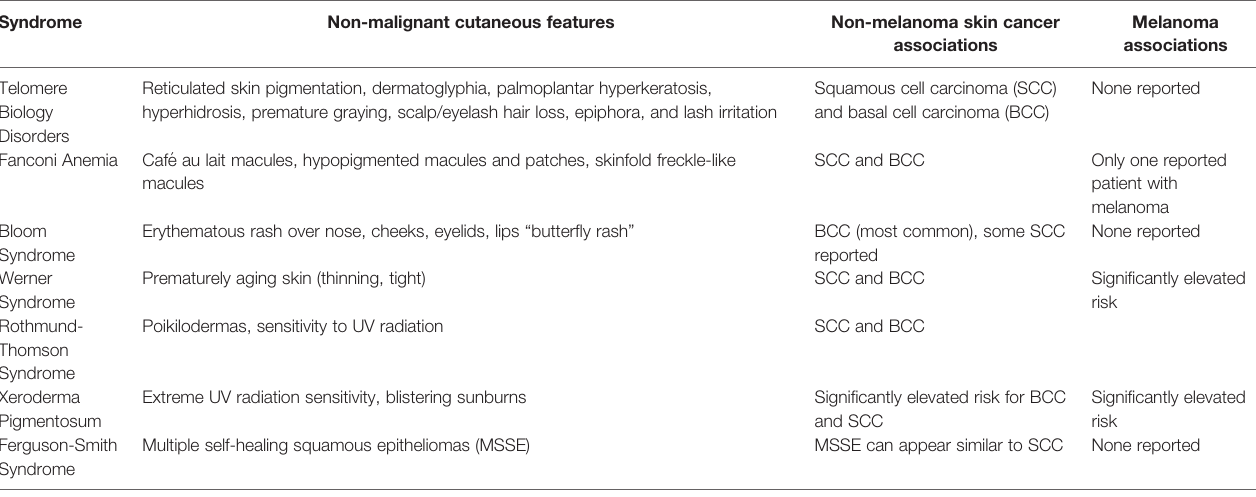
TABLE 2 | Malignant and Non-Malignant Cutaneous Findings in Cancer Predisposition Syndromes.